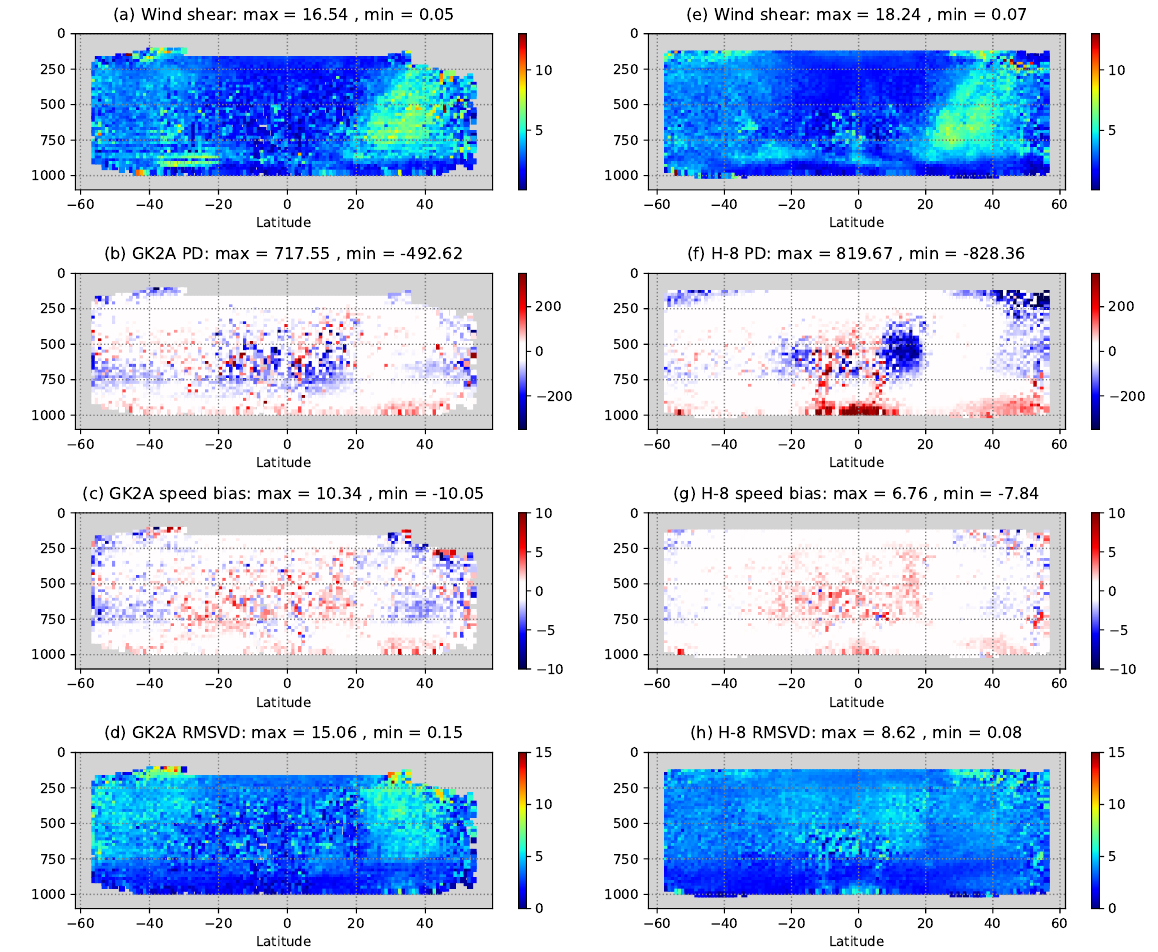
Figure 8. Zonal mean latitude-pressure cross-sections of wind shear, pressure differences, speed biases and the RMSVD for GK2A IR winds ( a – d , left) and H-8 IR winds ( e – h , right) during December 2020. Data filtered for QIFY < 90, SAZA > 64 ◦ (GK2A) or QIFN < 85, SAZA > 68 ◦